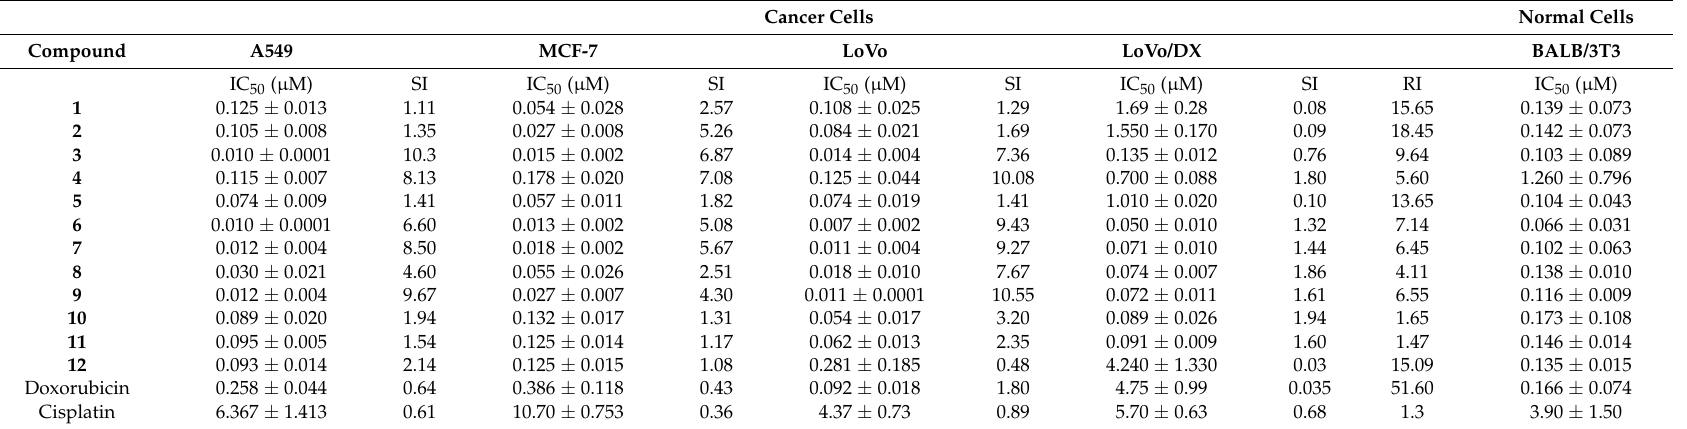
Table 1. Antiproliferative activity of colchicine ( 1 ) and its derivatives ( 2 – 12 ) compared with antiproliferative activity of standard anticancer drugs doxorubicin and cisplatin and the calculated values of resistance index (RI) and selectivity index (SI) of tested compounds.